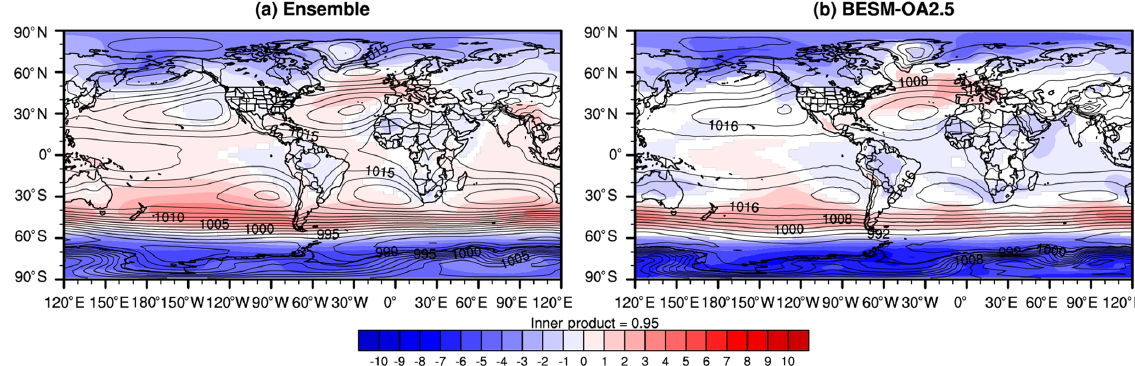
Figure 11. Difference (averaged over years 120–150) in sea level pressure (SLP; hPa) between the two scenarios (abrupt4xCO2 minus piControl; shaded) and SLP under piControl conditions (contours) in the CMIP5 model ensemble (a) and BESM-OA2.5 (b) . The white areas have confidence levels less than 90%.